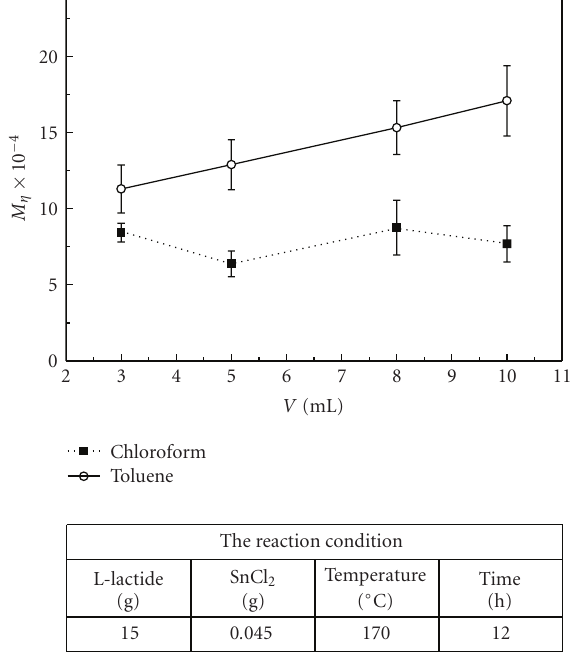
Figure 2: The e ff ect of solvent type on M η of PLAs.